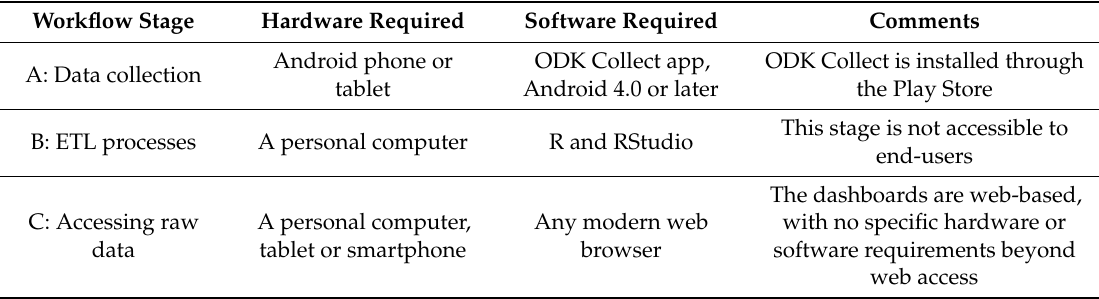
Table 3. Hardware and software requirements for the di ff erent data workflow stages within the EARS